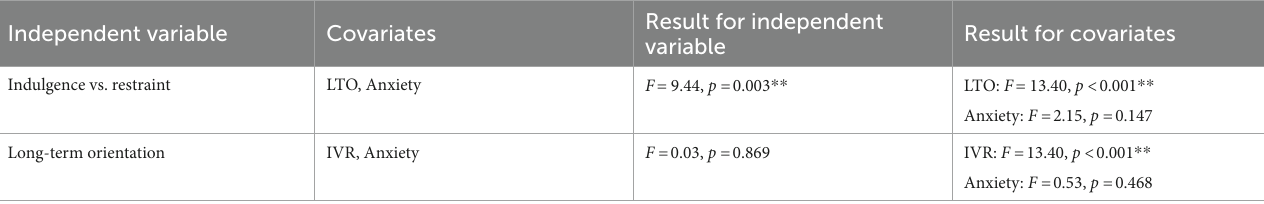
Result for independent variable